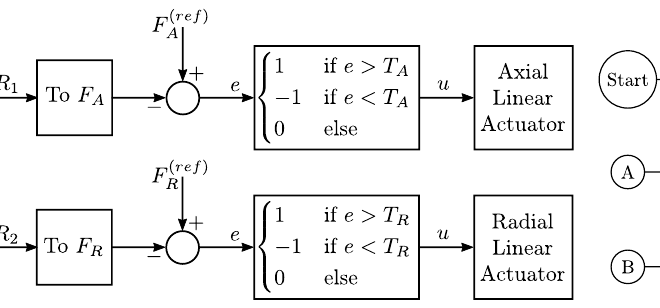
Figure 15: Control scheme for both linear actuators.